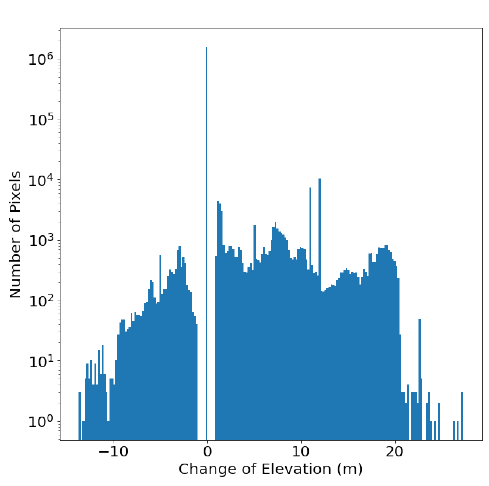
Figure 8. Pixel distribution in